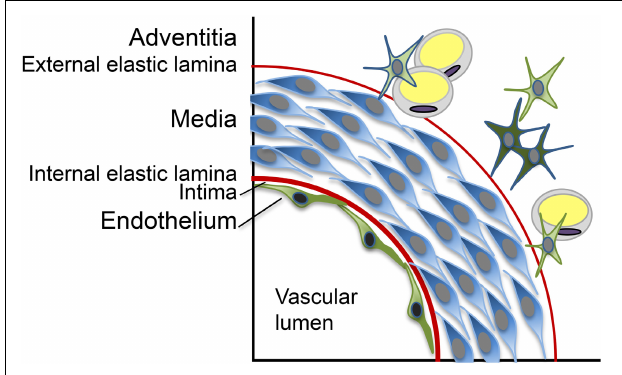
FIGURE 1 | Schematic representation of the layers in the vascular